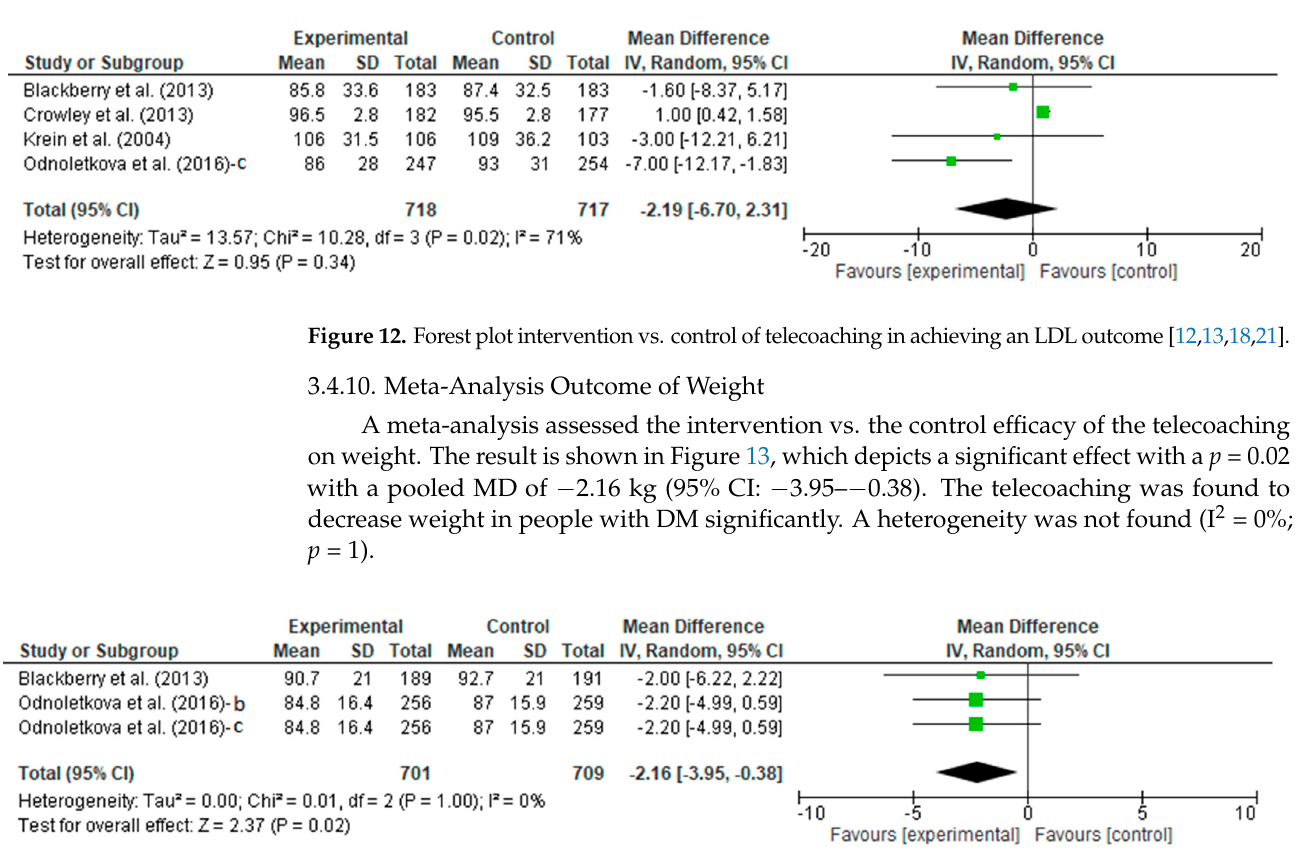
Figure 13. Forest plot intervention vs. control of telecoaching in achieving a weight outcome [12,21,22].